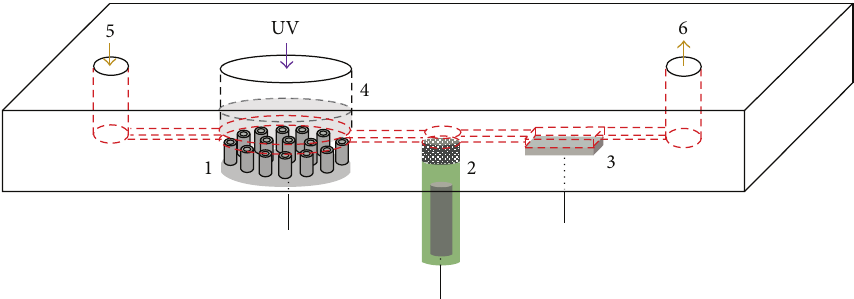
Figure 1: The structure of the thin-layer reactor: (1) TiO 2 nanotube array electrode; (2) saturated Ag/AgCl reference electrode; (3) Pt counter electrode; (4) quartz window; (5) flow inlet; (6) flow outlet.